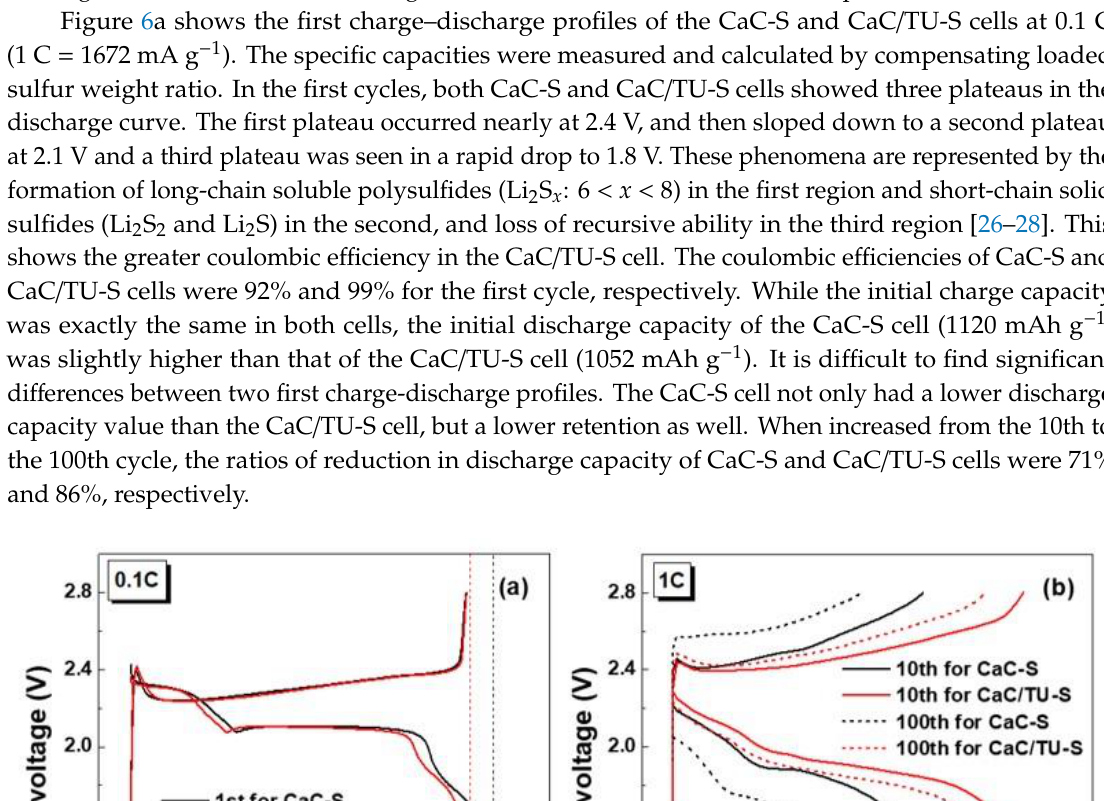
Figure 6. Charge/discharge profiles of the CaC-S and CaC/TU-S cells: ( a ) 1st cycle at 0.1 C rate; ( b ) 10th and 100th cycles at 1 C rate.